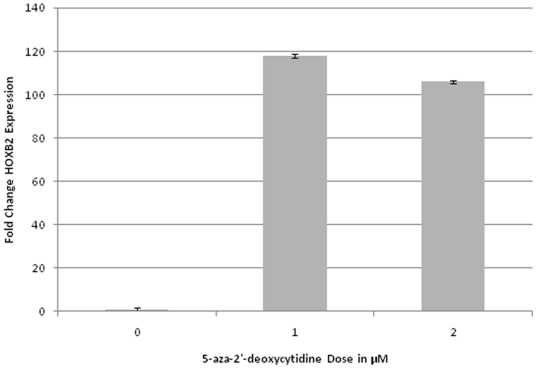

HOXB2 is re-expressed following treatment of HTB-9 bladder cancer cells with 5-aza-2′deoxycytidine.Quantitative RT-PCR analysis was used to determine the gene expression of HOXB2 in human bladder carcinoma cell line HTB-9, following a 5-day treatment with 1 or 2 µM 5-aza-2′-deoxycytidine or mock treatment. Bars represent the mean fold change in expression compared to mock treatment for 4 or 6 replicate experiments, and error bars denote the standard errors.